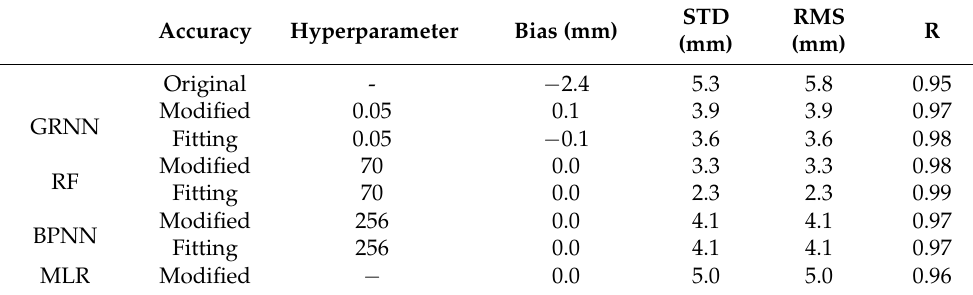
Table 2. Annual MODIS–GNSS PWV model results compared to GNSS PWV.